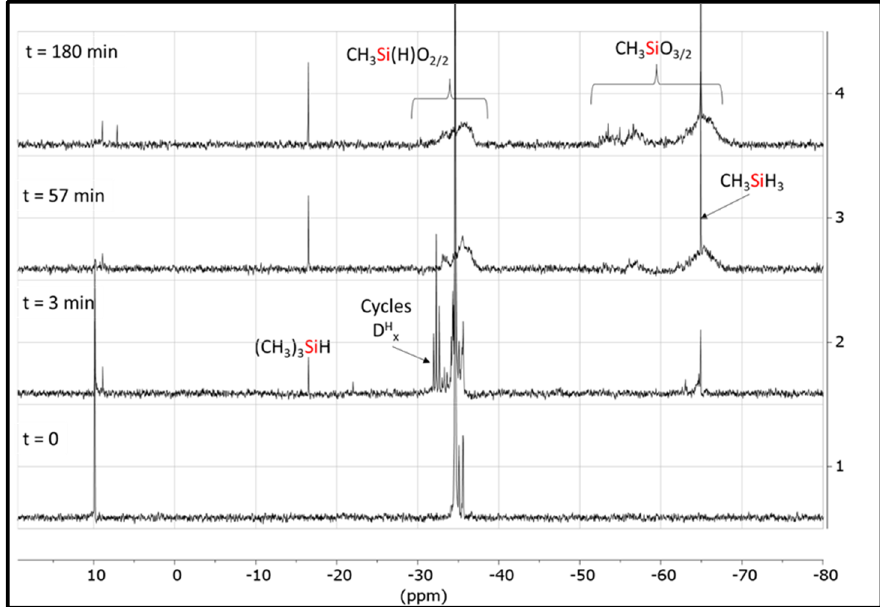
Figure 3. The 29 Si NMR spectra acquired during the reaction of 20 wt% PHMS solution in toluene in the presence of 1 × 10 − 3 mol/L of B(C 6 F 5 ) 3 at 30 °C.